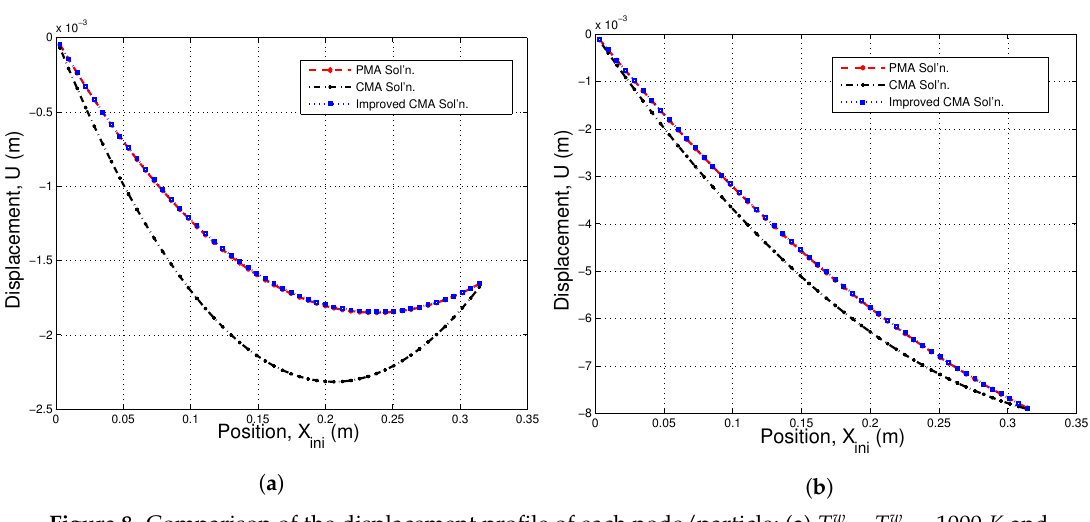
Figure 8. Comparison of the displacement profile of each node/particle; ( a ) T w ε = 0.005; ( b ) T w